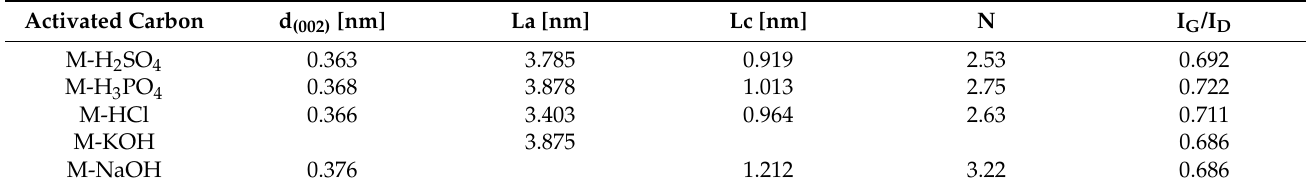
Table 1. Structural parameters of activated carbons obtained from XRD, and I G /I D ratios calculated from Raman measurements.